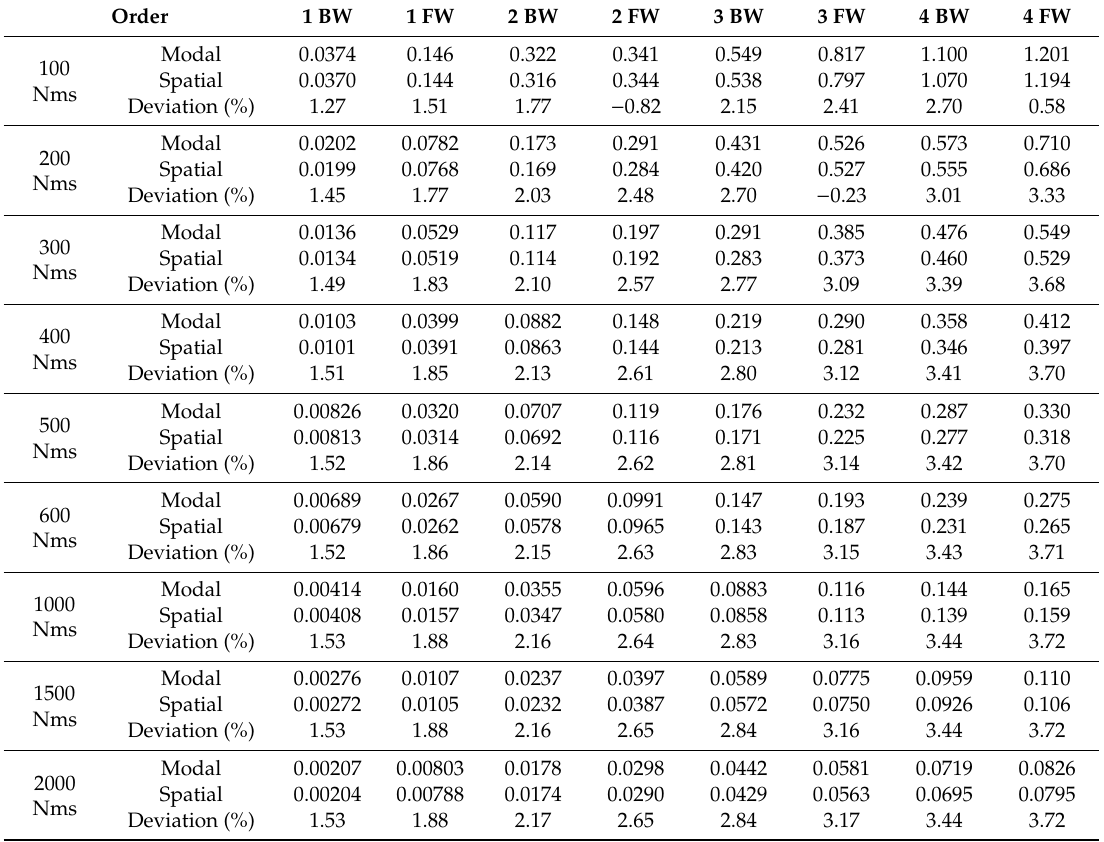
Table 17. Comparison between modal and spatial